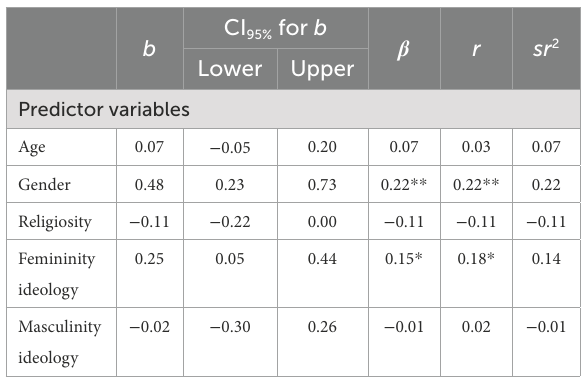
TABLE 5 Linear multiple regression predicting social media for social compensation.